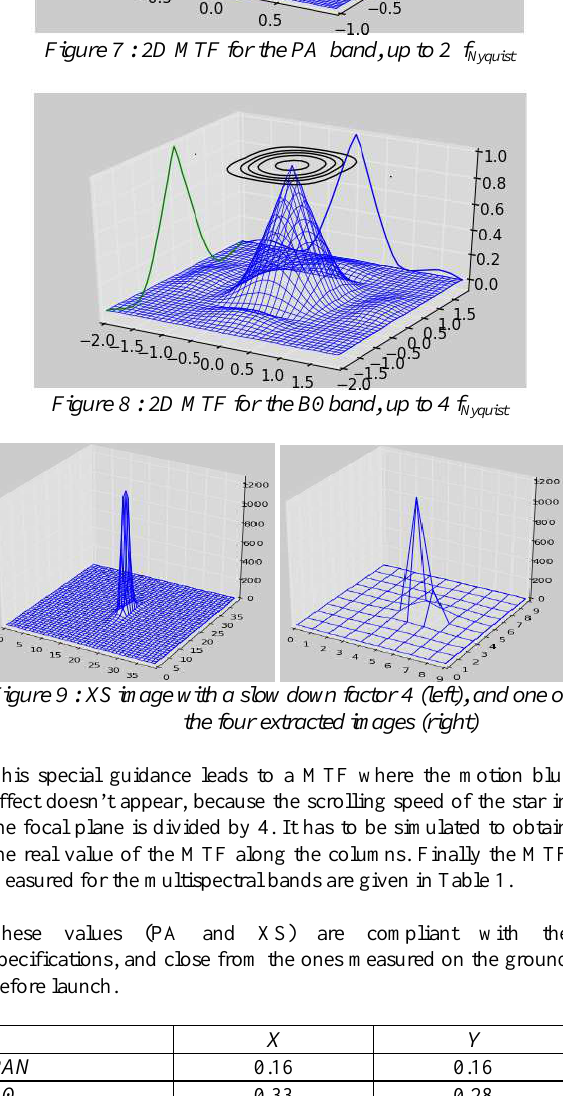
Figure 11 : defocus evolution measured in IAZ (blue) and with stars